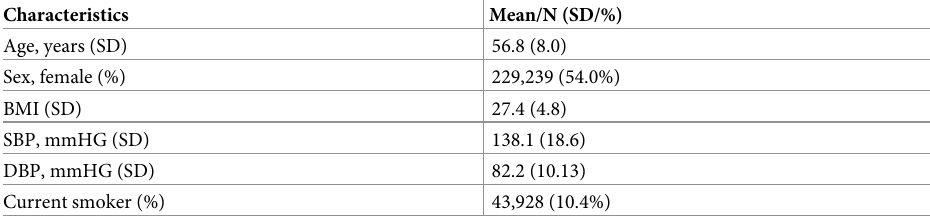
Table 1. Descriptive characteristics of the UK Biobank participants (N = 424,439) included in PheWAS analyses. Characteristics